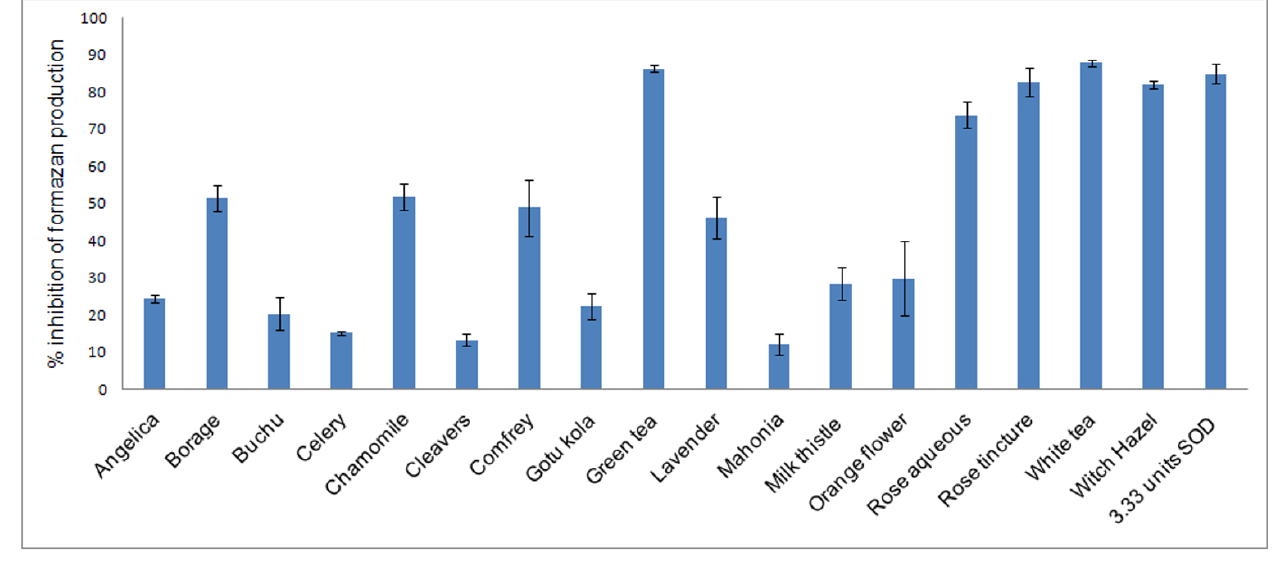
Appendix data table . Table showing numerical data values for all assays performed. Click here for